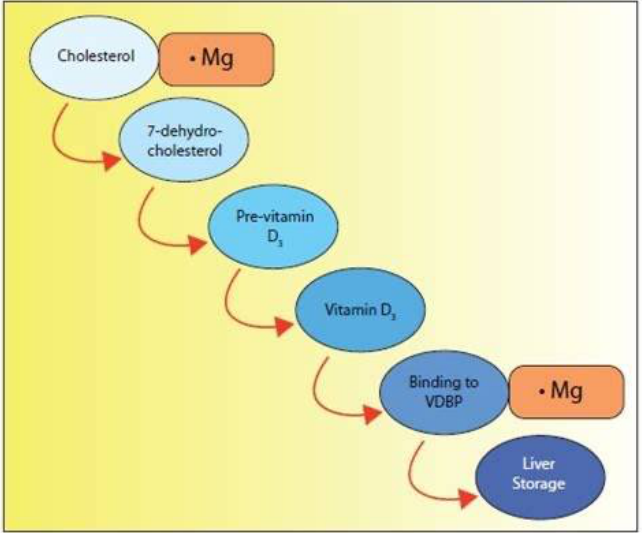
Figure 2. Even the synthesis of the substrate upon which solar derived D3 is produced requires